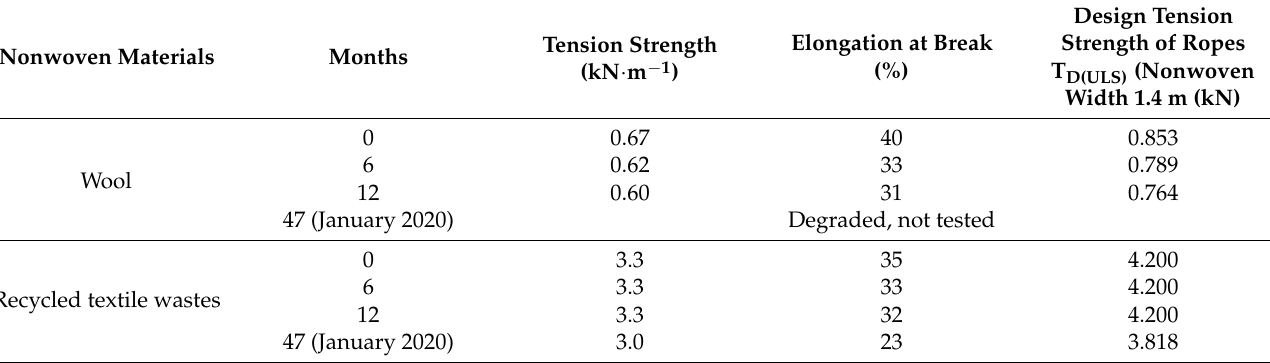
Table 4. Properties of the textile waste rope materials according to [24,25] (after 0, 6, and 12 months) and this research (location 4).